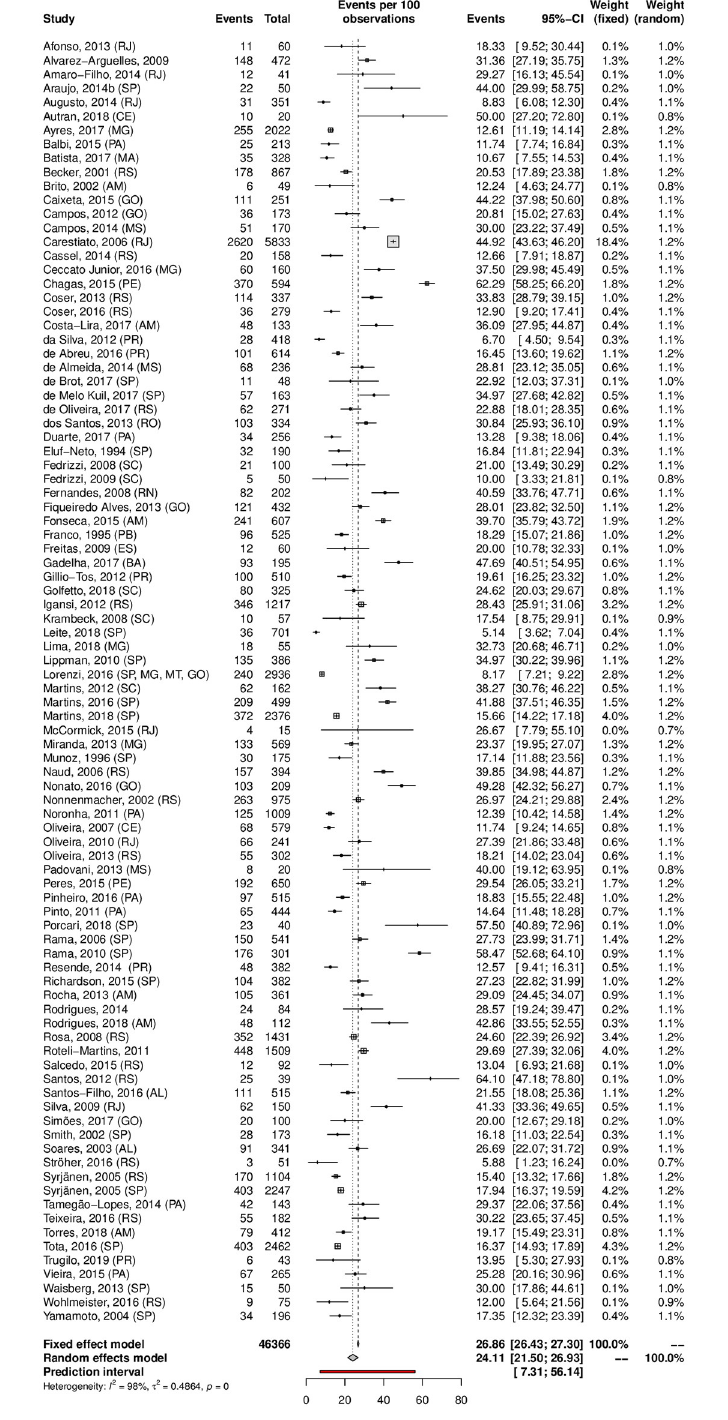
Fig 5. Prevalence of cervical HPV infection in low-risk populations. Forest plot of a metanalysis of studies reporting prevalence of cervical infection by HPV in low-risk populations in Brazil.